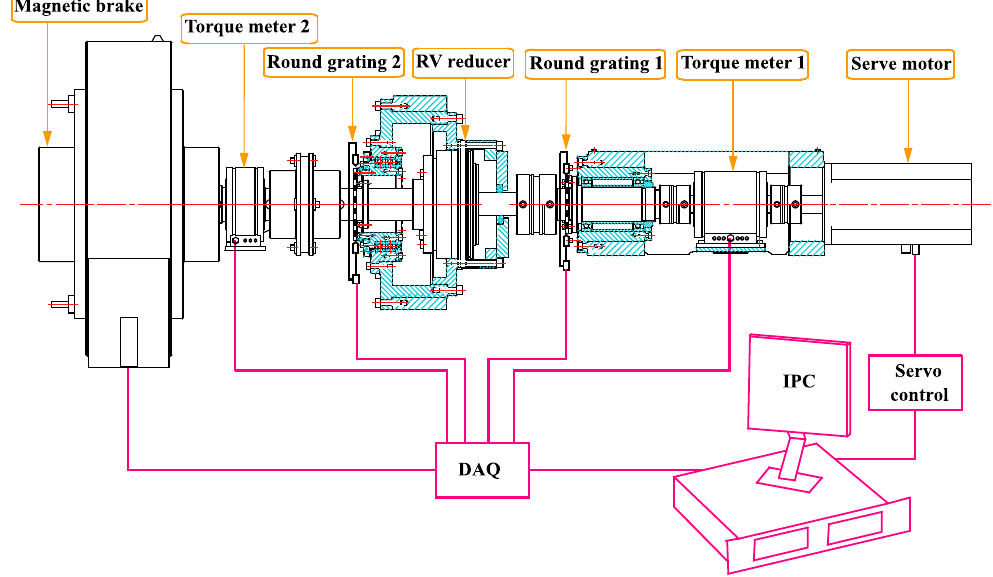
Figure 9. Control system of transmission performance tester. Table 3. Parameter list of sensors.